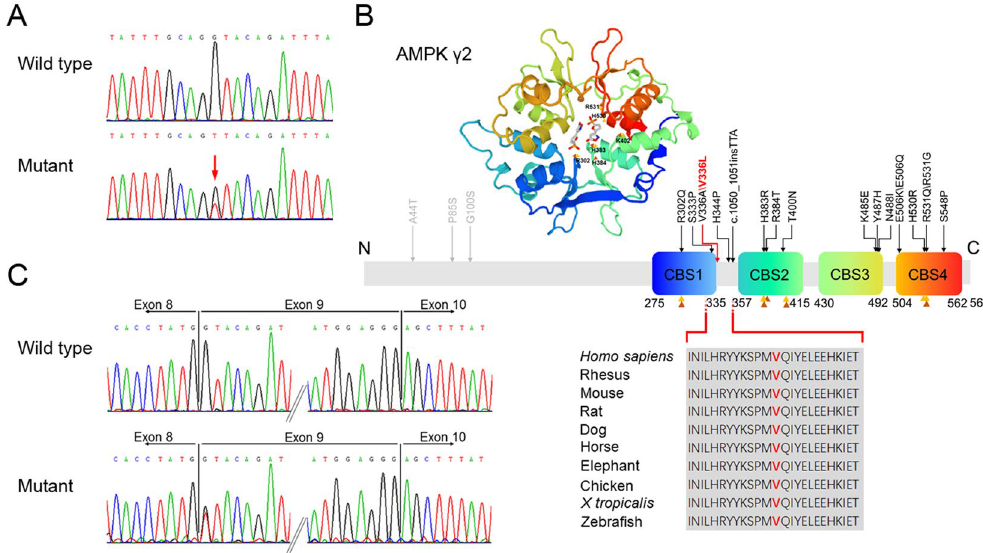
Figure 4. Genetic analysis identified a novel missense mutation V336L in a family with PRKAG2 syndrome. ( A ) DNA sequencing chromatogram shows a heterozygous G > T transition at nucleotide 1006 of PRKAG2 . ( B ) Three-dimensional model and schematic of the AMPK- γ 2 subunit and all identified PRKAG2 mutations (mutations with grey symbols represent possible disease-causing mutation, mutations with black symbols represent disease-causing mutation; data obtained from Human Gene Mutation Database, www.hgmd. org). Residue V336 is located adjacent to the CBS1 domain and is highly conserved across species. Orange triangle symbols point to AMP binding sites and brown ones point to ATP binding sites (data obtained from